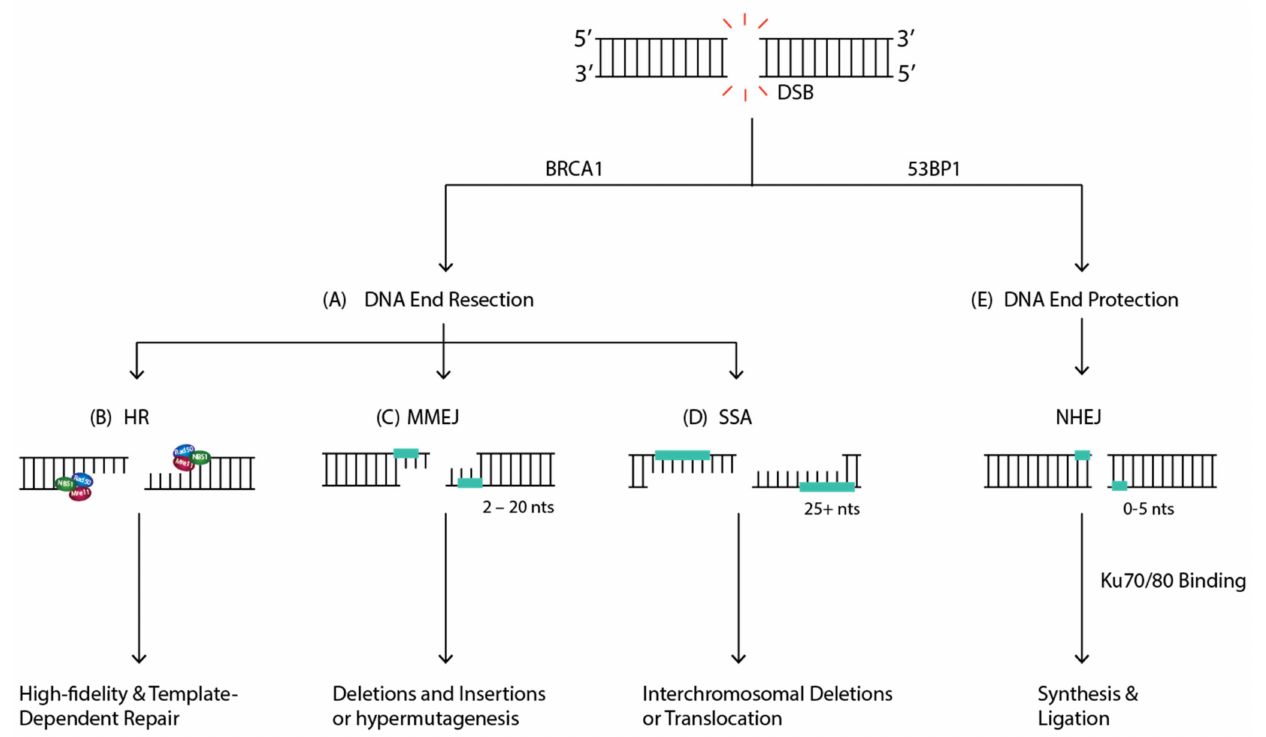
Figure 6. The Different Outcomes of DSB Repair. When a DSB forms, one of two things can occur, ( A ) DNA end resection can dictate pathway choice. If DNA ends are resected, one of three pathways can be used to repair the lesion: Homologous Recombination (HR), Single-Strand Annealing (SSA), or Microhomology-mediated End Joining (MMEJ). ( B ) HR repair will continue if the cells are in S/G2 phase and will result in high-fidelity and template dependent DSB repair. If there is no sister chromatid available in the cell, one of two pathways can be used for repair: MMEJ or SSA. ( C ) MMEJ involves microhomology, ranging from 2 to 20 nucleotides in length and can ultimately result in genomic instability in the form of deletions and insertions in chromosomes or hypermutagenesis. ( D ) SSA requires end resection and complementary sequences more than 25 nucleotides in length and can generate interchromosomal deletions or translocations. ( E ) If the DNA ends are protected, canonical NHEJ (c-NHEJ) will dominate where Ku70/80 heterodimer will bind, resulting in minimal end processing, synthesis, and